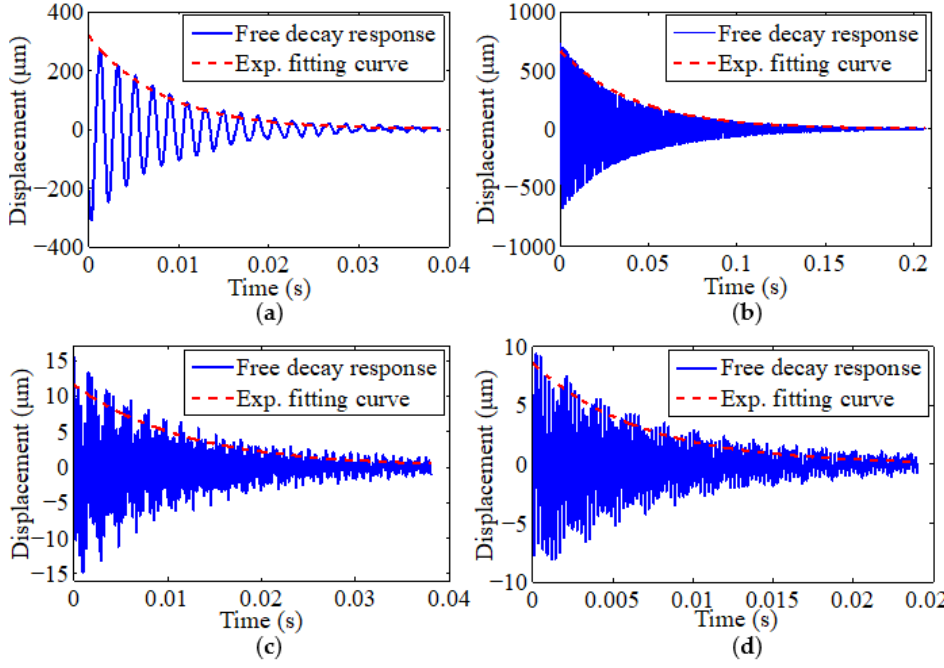
Figure 6. Identified exponential decay curves vs. tested resonance free decay responses of torque motor without MF. ( a ) First mode; ( b ) second mode; ( c ) third mode; ( d ) fourth mode.